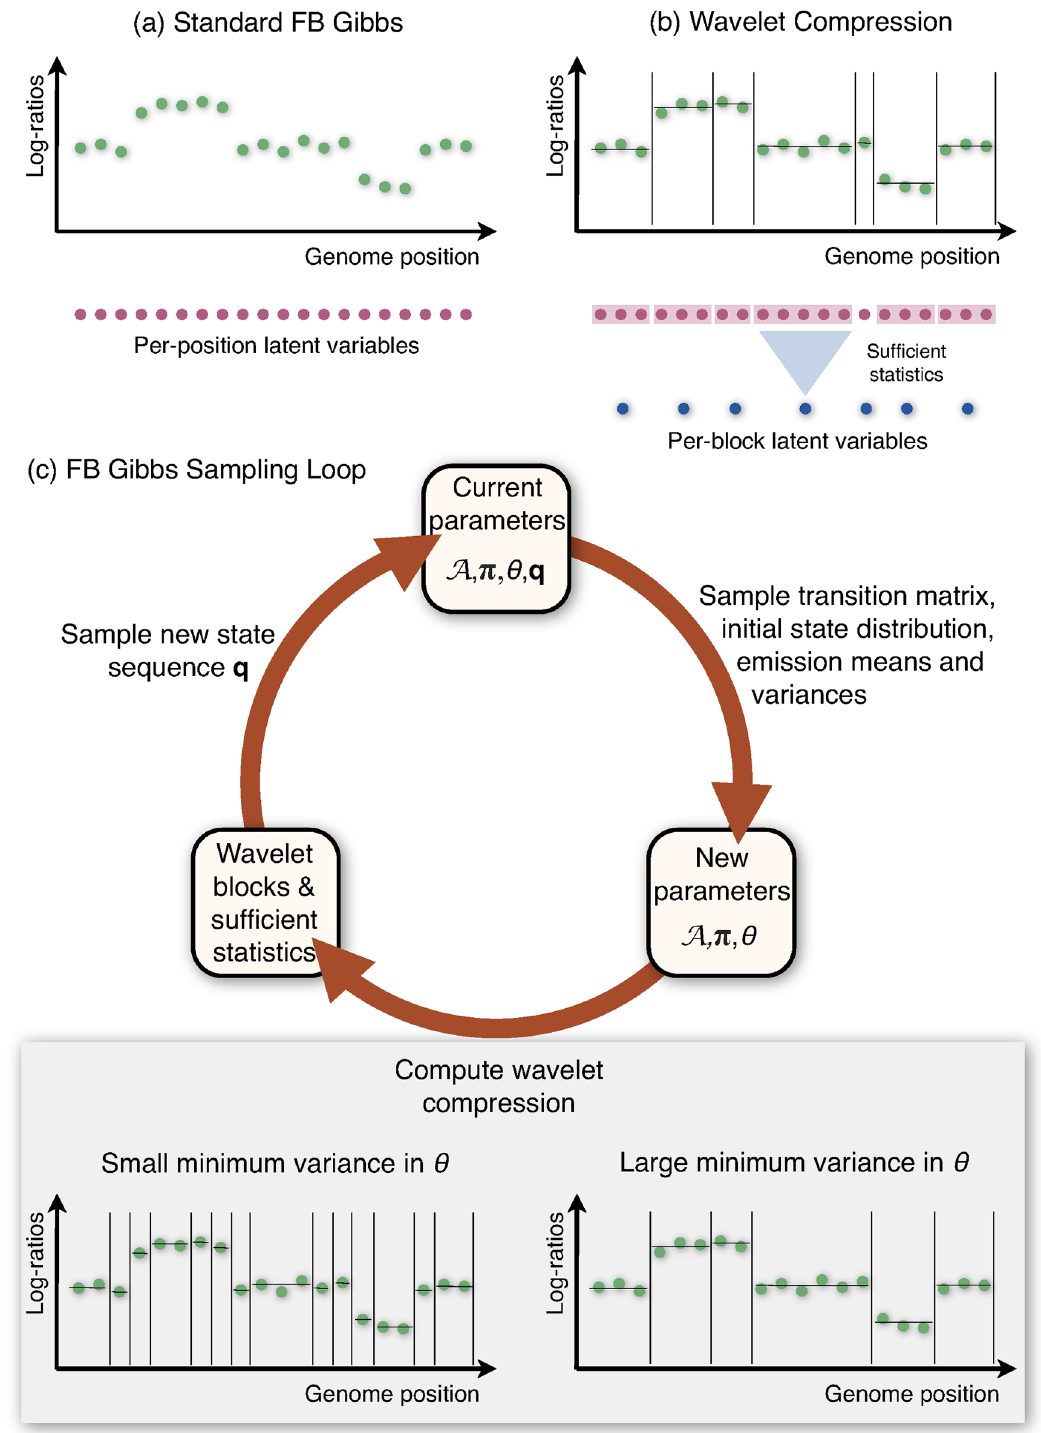
Fig 1. Overview of HaMMLET. Instead of individual computations per observation (panel a), Forward-Backward Gibbs Sampling is performed on a compressed version of the data, using sufficient statistics for block-wise computations (panel b) to accelerate inference in Bayesian Hidden Markov Models. During the sampling (panel c) parameters and copy number sequences are sampled iteratively. During each iteration, the sampled emission variances determine which coefficients of the data ’ s Haar wavelet transform are dynamically set to zero. This controls potential break points at finer